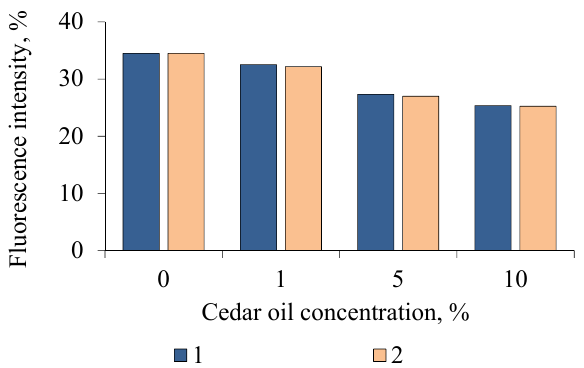
Fig. 6. Results of in vitro determination of the antioxidant effect of cedar oil on the cultured MDCK1 cells for 60 min: (1) oil (cold pressing); (2) oil (heat pressing). The data are expressed as a mean ± standard deviation ( n = 5).